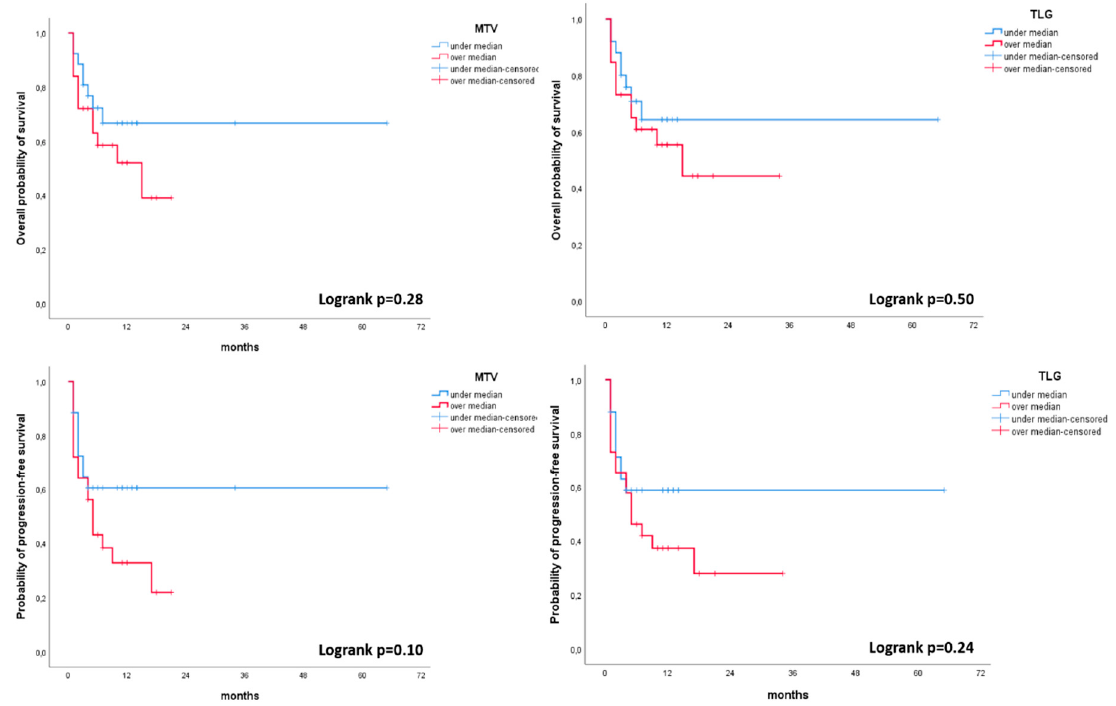
Figure 1. Kaplan–Meier plot analysis for MTV and TLG with both progression free survival (PFS) and overall survival (OS). Population was grouped by the median value of MTV (74.1) and TLG (310.8).